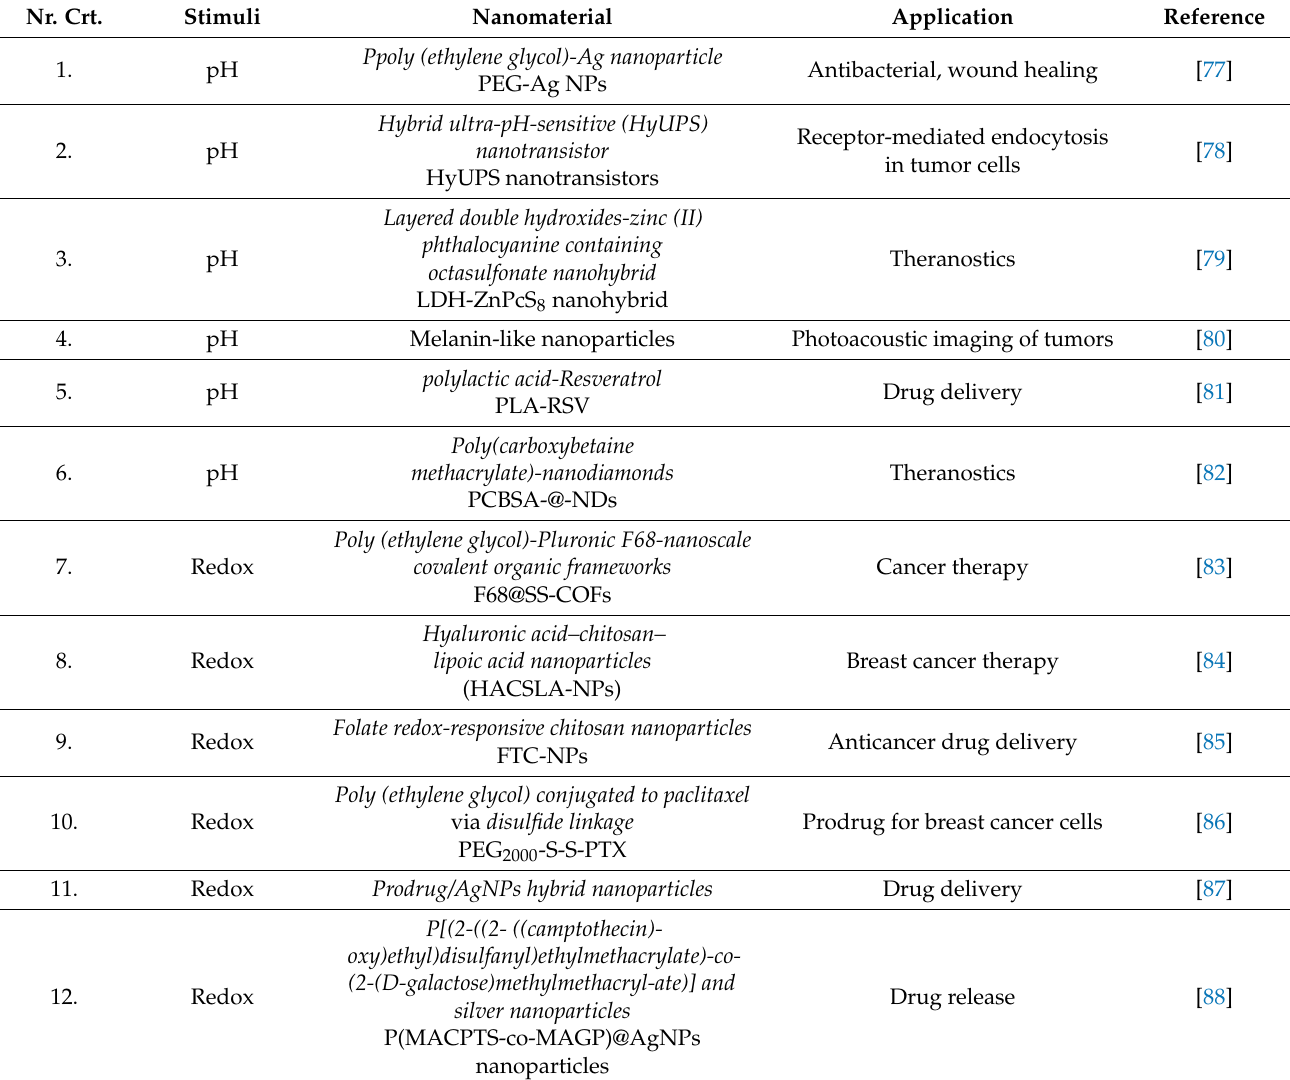
Table 2. Examples of chemical-responsive nanomaterials and their biomedical applications. Nr.